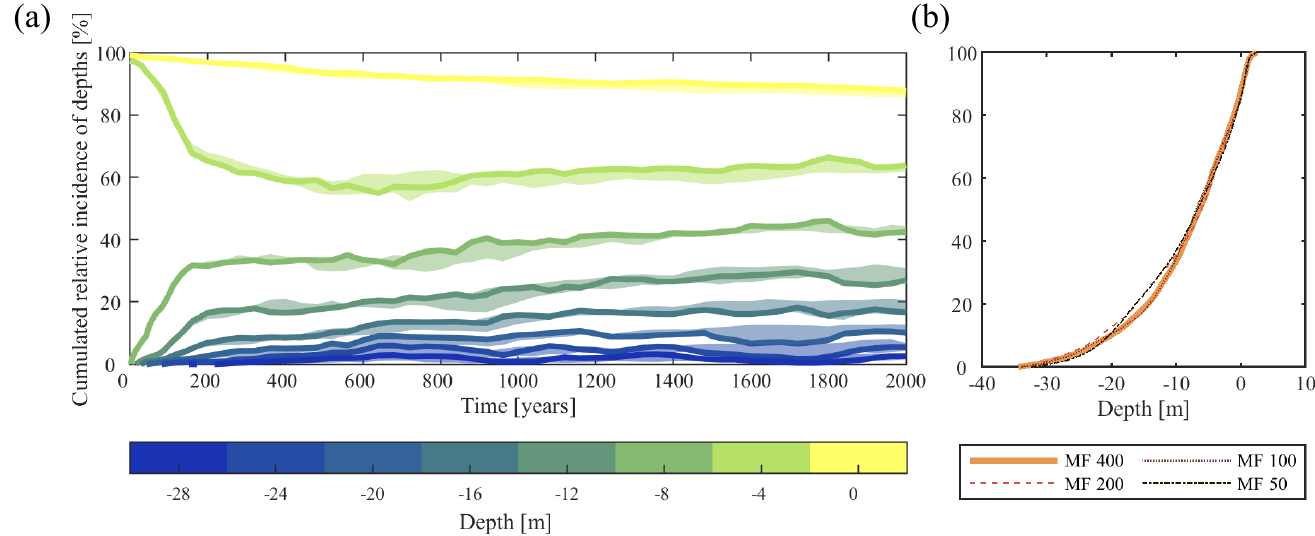
Figure 2. Validation of the morphological factor by ( a ) the development of cumulative relative incident (in [%]) of depth contour lines as the colored span of contour lines from the MorFacs 400, 200, 100, 50 (MorFac 400 in thick) and ( b ) the individual hypsometric curves after 2000